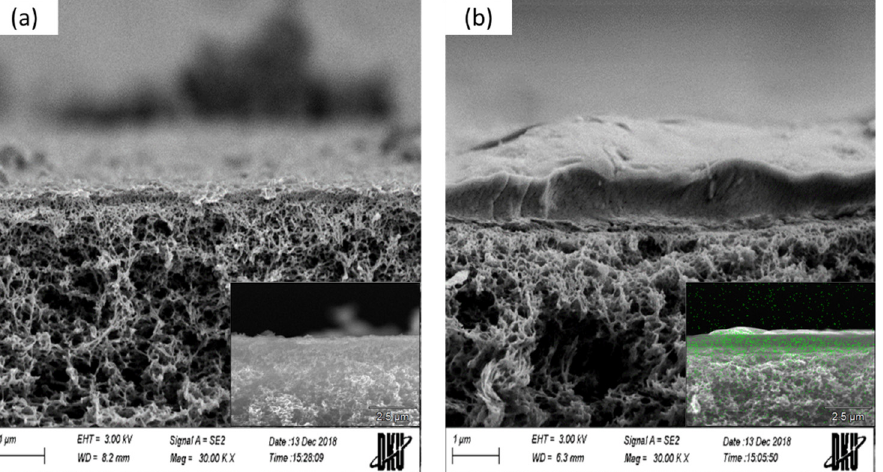
Figure 8. SEM cross-section images of NF membranes before/after ionomer coating. ( a ) NF8S_Ref- before, ( b ) NF8S_C-after and F-EDS.